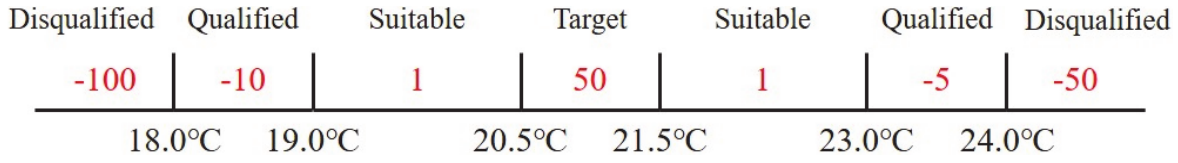
Figure 6. Design of reward function 2. Figure 7. Design of reward function 3. Figure 7. Design of reward function